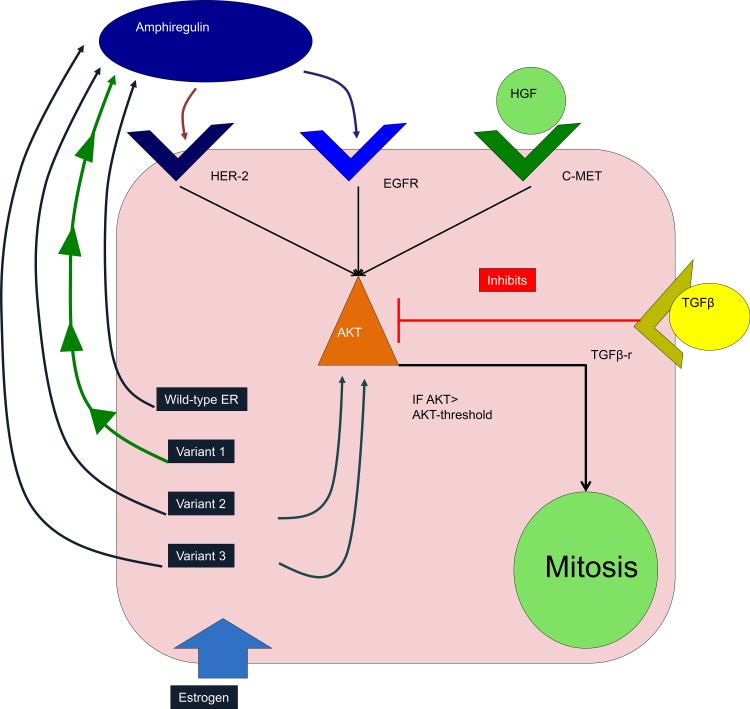
Overview of intracellular signaling for duct epithelial cells in the Duct Epithelium Agent-based Model (DEABM).Estrogen initiates the production of amphiregulin in the Wild-type ER + condition. In turn amphiregulin, along with HGF produced by fibroblasts, increases intracellular levels of AKT; AKT levels rising beyond a set threshold trigger mitosis. Transforming growth factor beta (TGF-β) inhibits growth by decreasing intracellular AKT. The DEABM allows for mutations resulting in hypothesized variant forms of ER that have varying growth promoting effects: Variant 1 causes cells to autonomously produce high levels of amphiregulin. Variant 2 causes estrogen to directly increase intracellular AKT, mimicking a form of non-genomic ER signaling. Variant 3 is a combination of Variants 1 and 2, causing cells to produce a moderate amount of autonomous amphiregulin as well as a moderate amount of direct AKT increase.